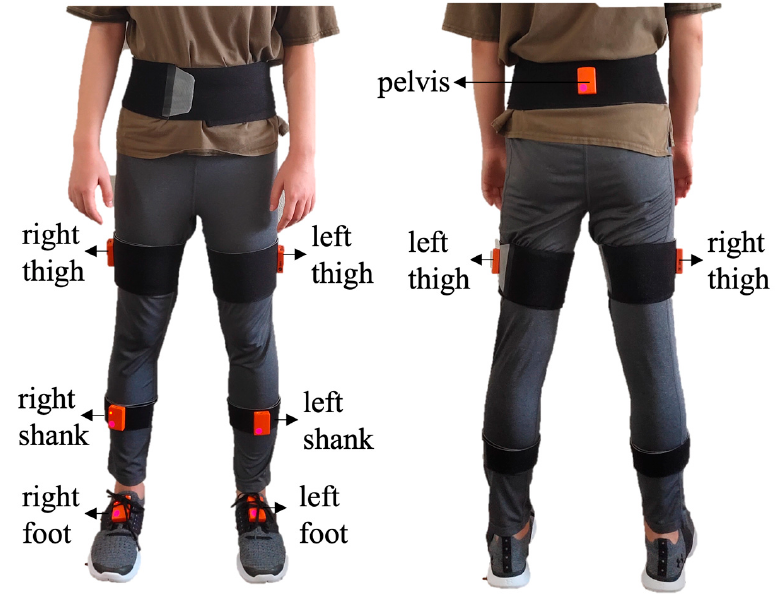
Figure 2. Seven IMU sensors were attached to the lower body.